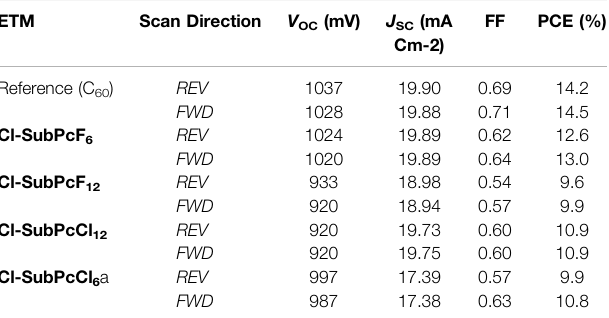
TABLE 1 | PV parameters of the most ef fi cient devices extracted from the corresponding J – V curves. FWD : forward scan (from J SC to V OC ), REV : reverse scan (from V OC to J sc